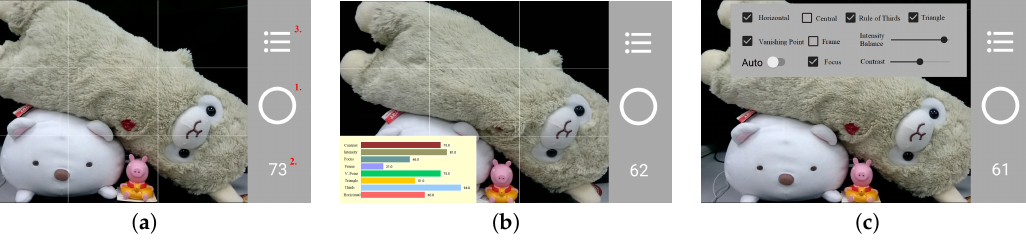
Figure 25. ( a ) Main interface. ( b ) The score for each composition method. ( c ) The interface for setting/selecting composition method (enlarge to see more